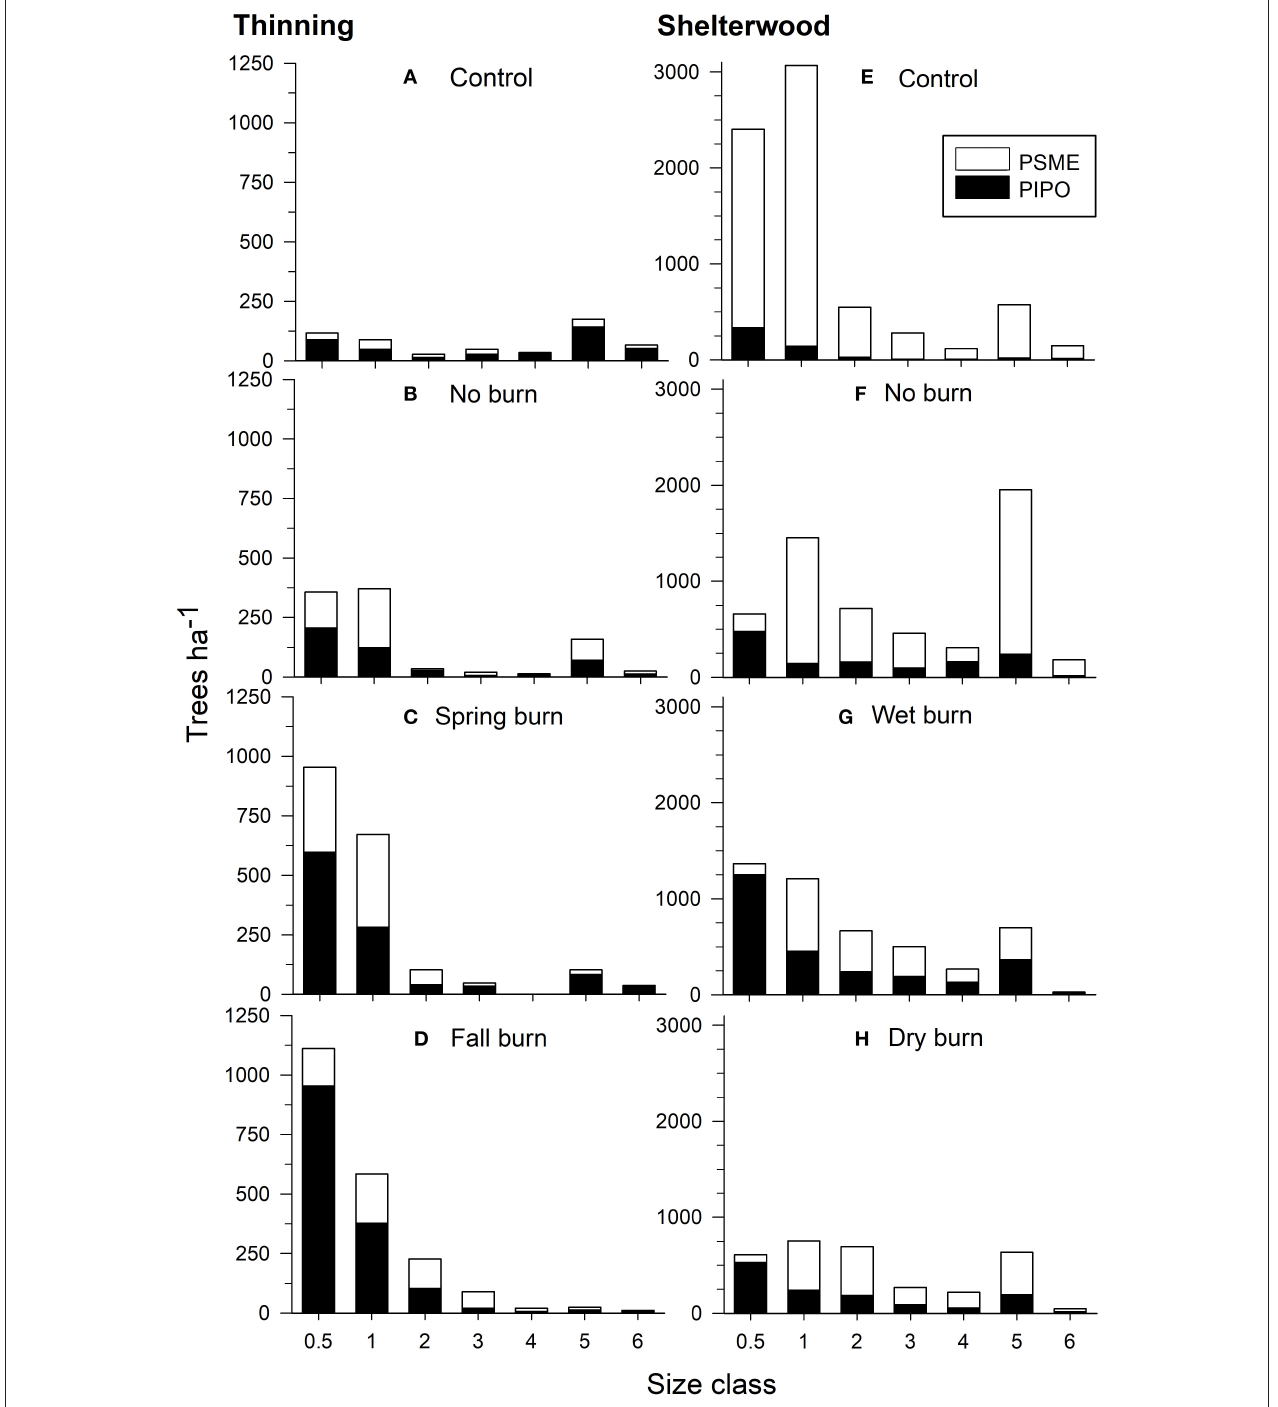
FIGURE 5 | Size class distributions for seedlings (height classes) and saplings (diameter classes) by treatment and species in the Thinning (A–D) and Retention Shelterwood (E–H) in 2015 (22 years post-treatment). Size classes: 0.5: ≤ 0.15m tall, 1: > 0.15–0.46m tall, 2: > 0.46–0.76m tall, 3: > 0.76–1.07m tall, 4: > 1.07–1.37m tall, 5: > 0.1–6cm DBH, 6: > 6.0–12cm DBH. Only Pinus ponderosa (PIPO) and Pseudotsuga menziesii (PSME) are displayed. Other species made up < 2%.